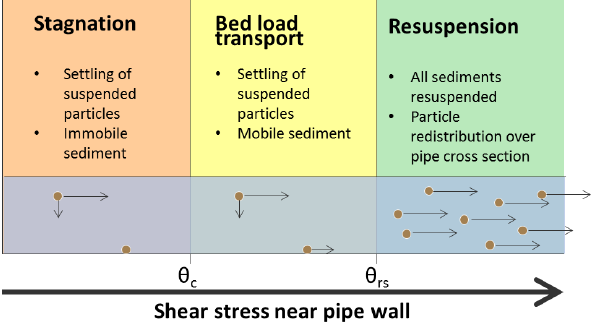
Figure 1. Conceptual representation of the particle transport model. Below a dimensionless critical shear stress (Shields number for in- cipient motion, θ c , red area) particles in suspension settle to the bot- tom of the pipe under the influence of gravity and, once settled, re- main immobile. Above the critical Shields number for particle en- trainment ( θ rs , green area), we assume that all particles are resus- pended instantly and redistributed uniformly over the cross section of the pipe. At intermediate shear stress conditions (yellow area), suspended particles settle and particles in the sediment phase move by means of bed-load transport. The transport phases are schemati- cally visualized in the blue